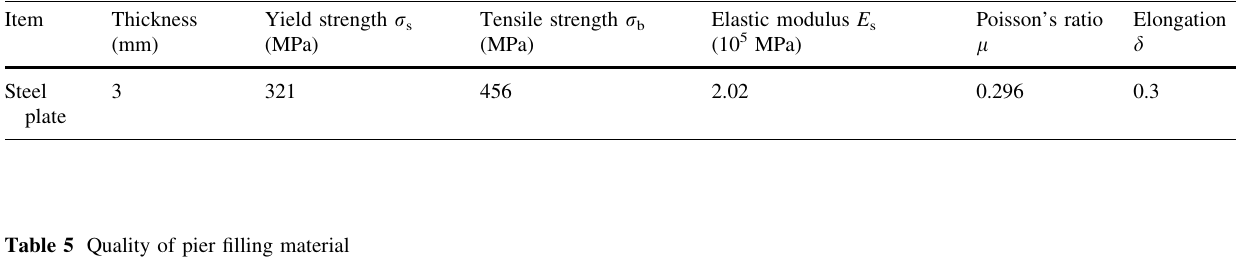
Table 5 Quality of pier filling material Filling volume (m 3